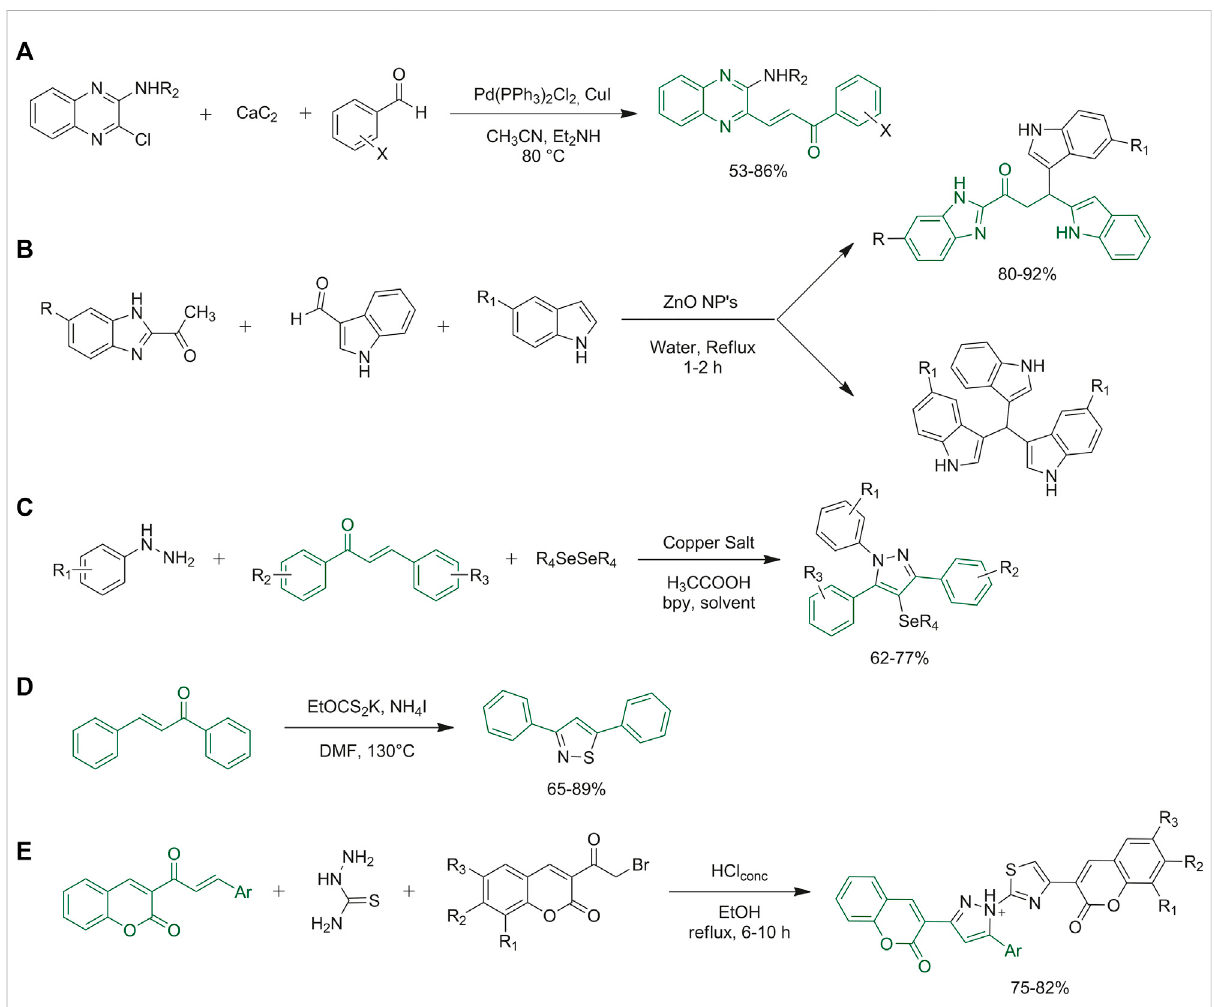
FIGURE 10 (A) Synthesis of (E) -3-(2-aminoquinoxalin-3-yl)-1-arylprop-2-en-1-one derivatives from 2-amino-substituted-3-chloroquinoxalines, calcium carbide, and aromatic aldehydes; (B) synthesis of indole-condensed benzimidazole chalcones via one-pot synthesis; (C) synthetic strategies for the synthesis of 1,3,5-triaryl-4-(arylselanyl)-pyrazoles through one-pot synthesis; (D) metal-free approach to get off various isothiazoles via three- component one-pot route: general synthesis; (E) synthetic strategy to obtain designed thiazolyl-pyrazole-biscoumarin via eco-friendly one- pot synthetic